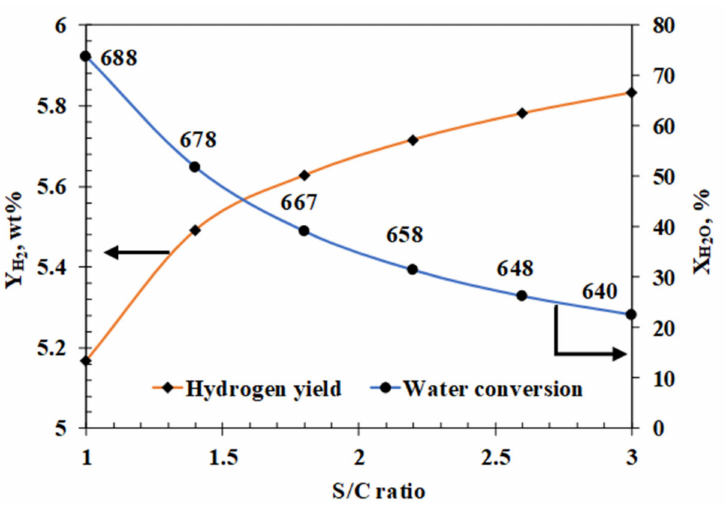
Figure 3. Influence of the amount of steam, expressed as S/C ratio, on hydrogen yield for equivalence ratio, λ = 0.25. For the base case, ATR and CO-shift occur at 3 bar and H 2 recovery is carried out at 10 bar. Equilibrium temperatures in Celsius degrees ( ◦ C) are included as data